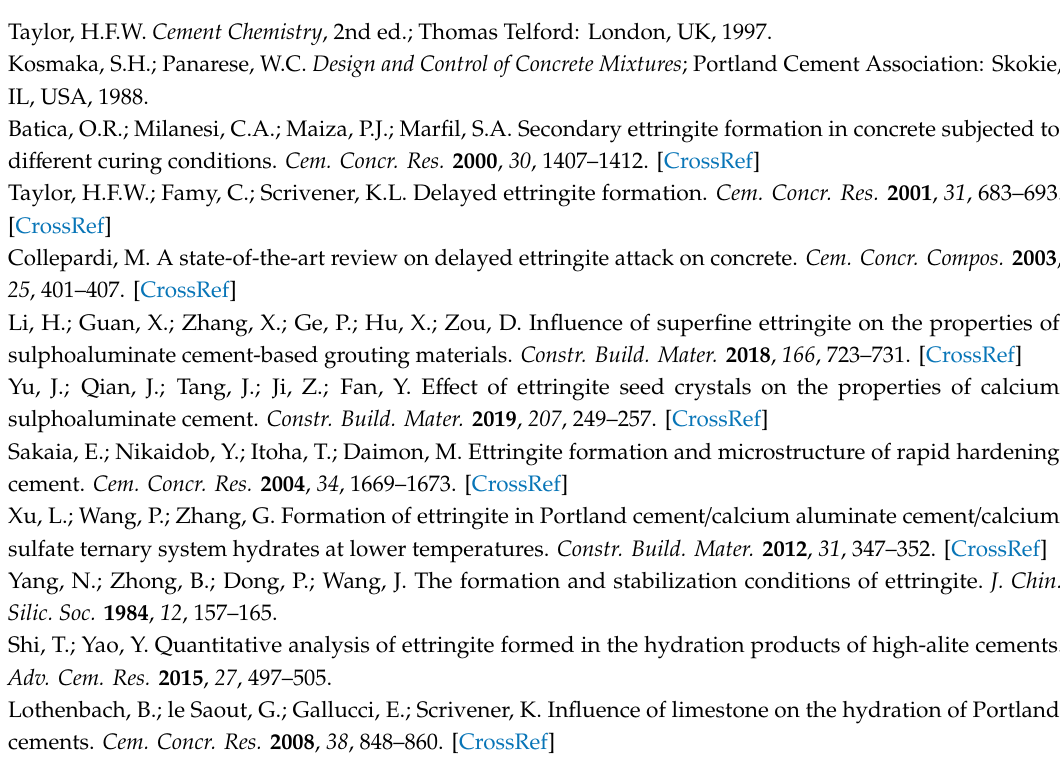
Figure S1: Rietveld refinement analysis of the raw OPC specimen, Table S1: Rietveld refinement analysis result of the raw OPC specimen, Figure S2: Rietveld refinement analysis of the raw HCPC specimen, Table S2: Rietveld refinement analysis result of the raw HCPC specimen, Figure S3: Verification XRD measurement on a hardened cement paste after 1 day of